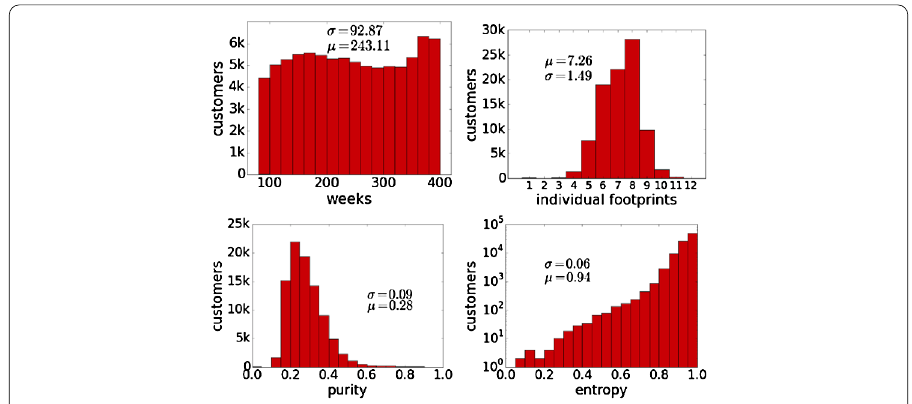
Figure 5 Individual footprints analysis. Distributions of customers per: number of weeks (upper left), number of individual footprints (upper right), purity (lower left), entropy (lower